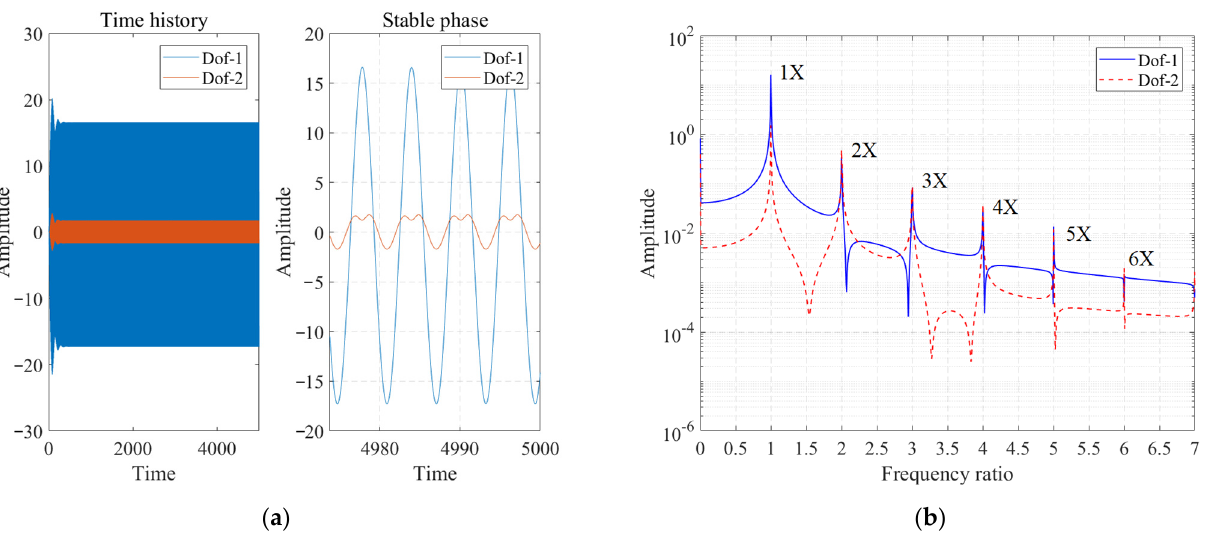
Figure 10. Time history and frequency spectra of the system with an excitation frequency of 1.02: ( a ) time history; ( b ) frequency spectrum.